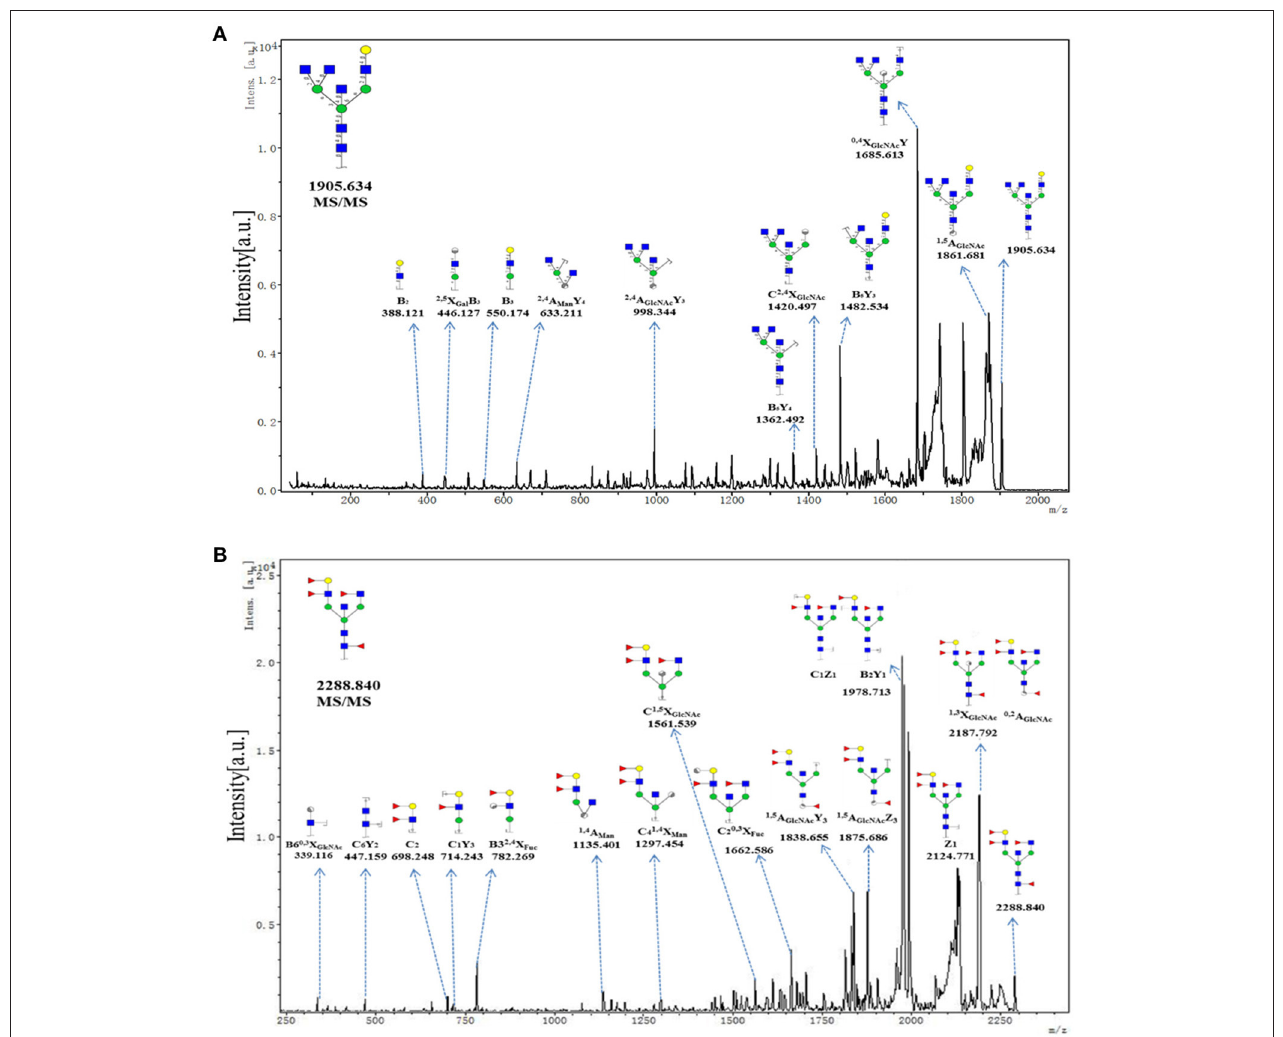
FIGURE 5 | MS/MS analysis of N-glycan precursor ions in MS spectra. Precursor ions were subjected to MS/MS analysis to obtain cleavages, including glycosidic cleavages, and cross-ring cleavages. Structures of cleavage ions and m/z -values are shown in tandem mass spectra. Two major N-glycan peaks were indicated: (A) m/z 1905.634, and (B)